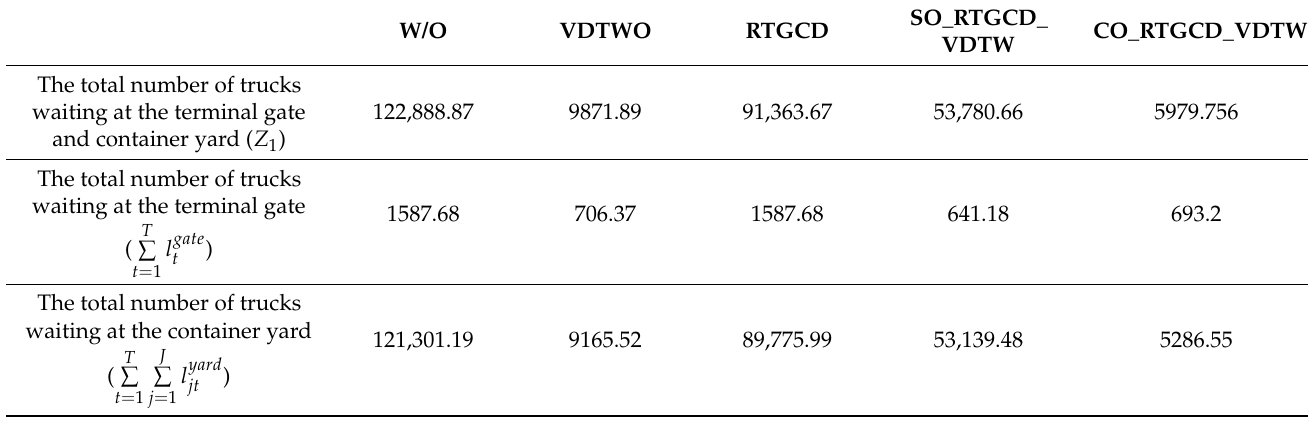
Table 3. The results of different optimization strategies.